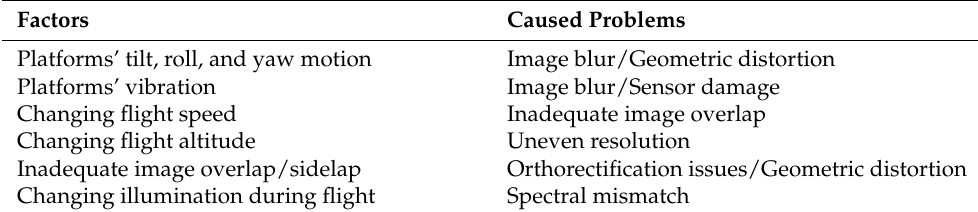
Table 4. Factors that affect image quality in UAVs’ operational